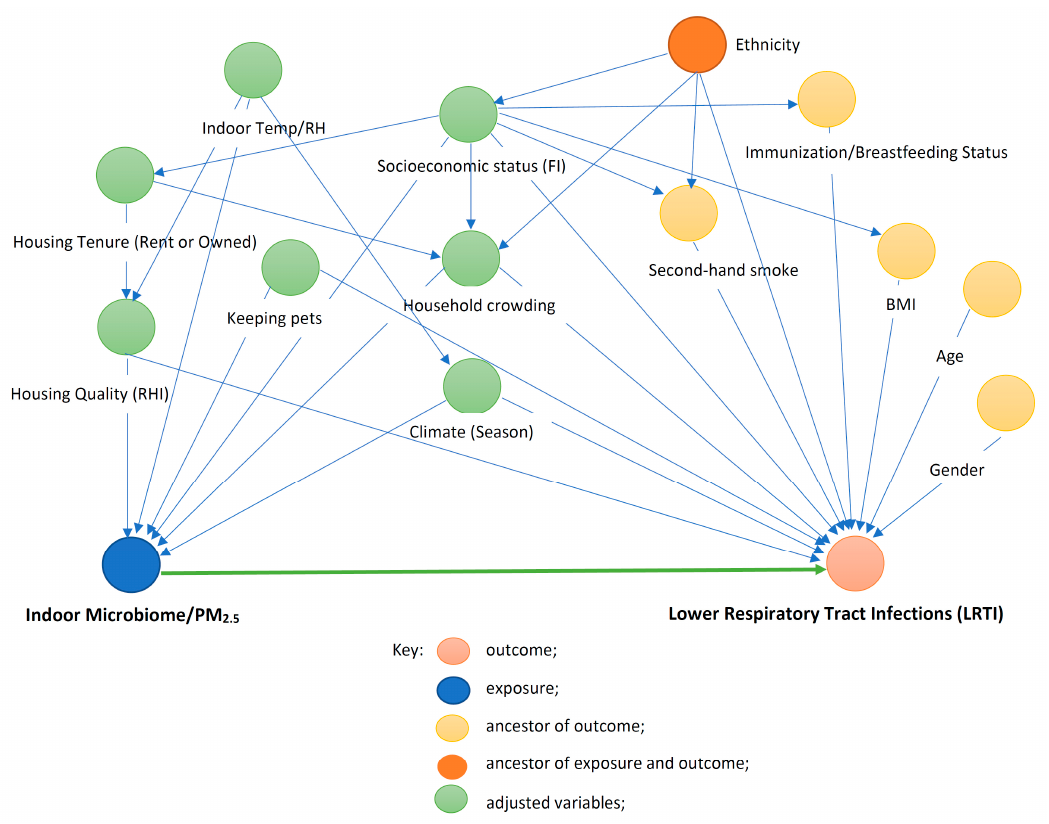
Figure 4. Directed acyclic graph (DAG) demonstrating causal relationships affecting the association between exposure to indoor microbiome (IM) / PM 2.5 and lower respiratory tract infections (LRTI). IM, indoor microbiome; PM 2.5, particulate matter size 2.5 µ m; RHI, respiratory hazard index; indoor Temp, indoor temperature; indoor RH, indoor relative humidity.